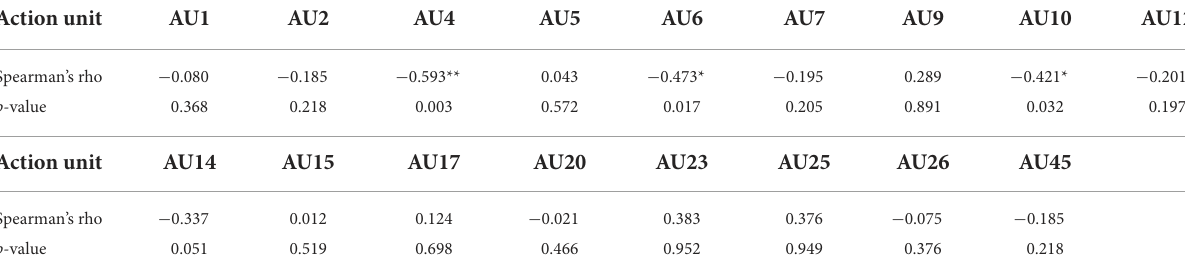
TABLE 8 Spearman’s correlations r (20) with users’ ratings to DC item 8. Action unit